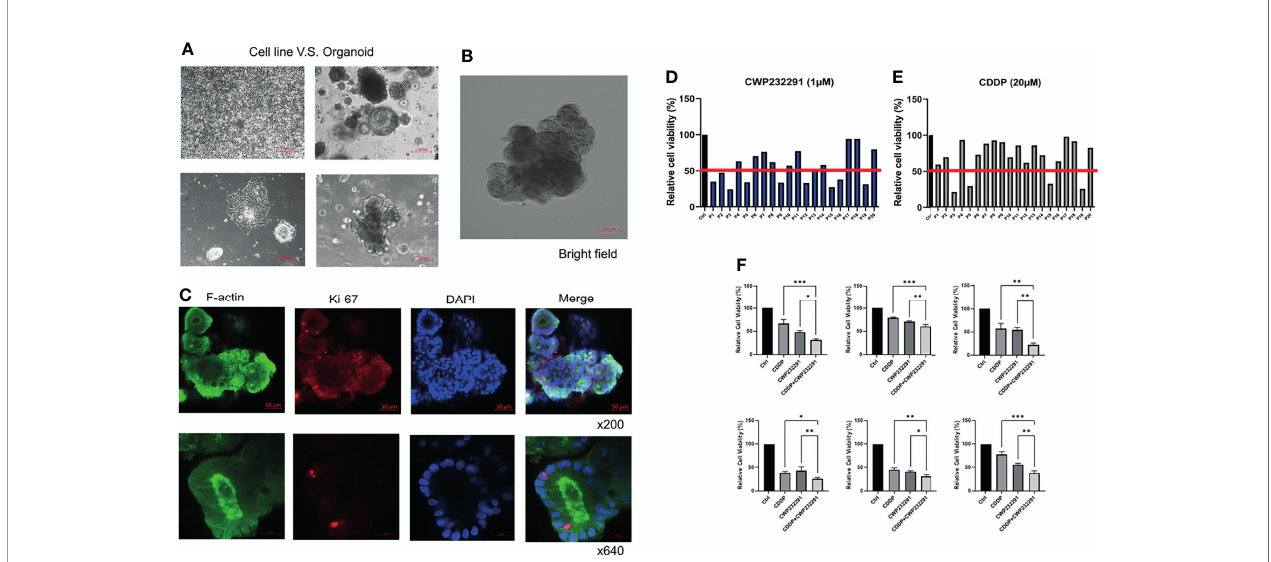
FIGURE 3 | CWP232291 inhibited the growth of ovarian cancer patient-derived organoids. (A) Morphologic comparison of cell lines and organoids (up: low-power fi eld; down: high-power fi eld). (B) The representative morphology of organoid in bright fi eld. (C) Organoid F-actin and Ki-67 staining. Twenty patient-derived organoids were established and treated with CWP232291 (1 µM) and cisplatin (20 µM). Organoids with over 50% growth inhibition were de fi ned as sensitive. Nine of twenty (P1, P2, P3, P5, P9, P12, P15, P16, P19) was sensitive to CWP232291 (D) while four (P3, P5, P15, P19) of twenty was sensitive to cisplatin (E) . (F) Six organoids were treated with CWP232291 (1 µM), cisplatin (20 µM) or the combination of these two compounds. The cell viability was determined by MTT assay.CDDP: cisplatin. Results were shown as mean ± SEM (*p ≤ 0.05, **p ≤ 0.01, ***p ≤